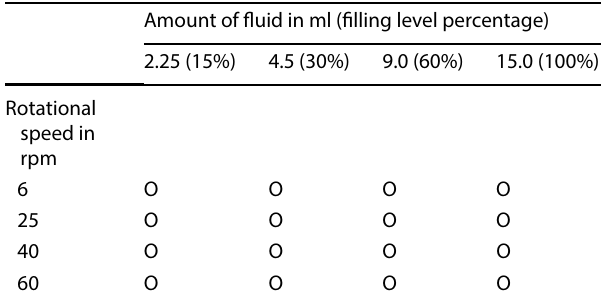
Aerolan 2410 emulsion